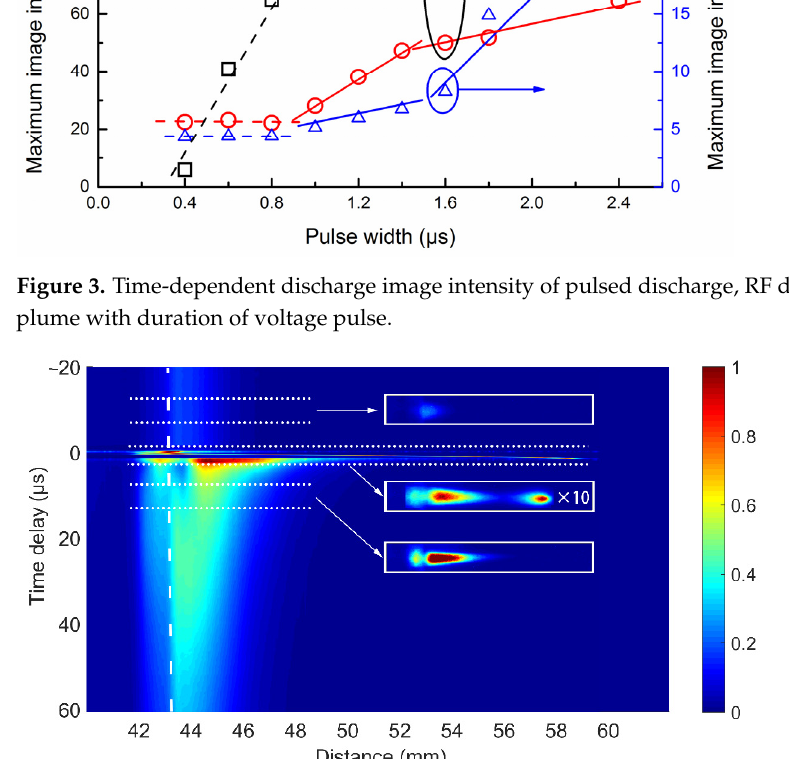
Figure 4. Temporal evolution of discharge spatial profile with the pulse duty cycle of 1.2% at the nozzle. Microsecond images of RF discharge are shown in the insert.